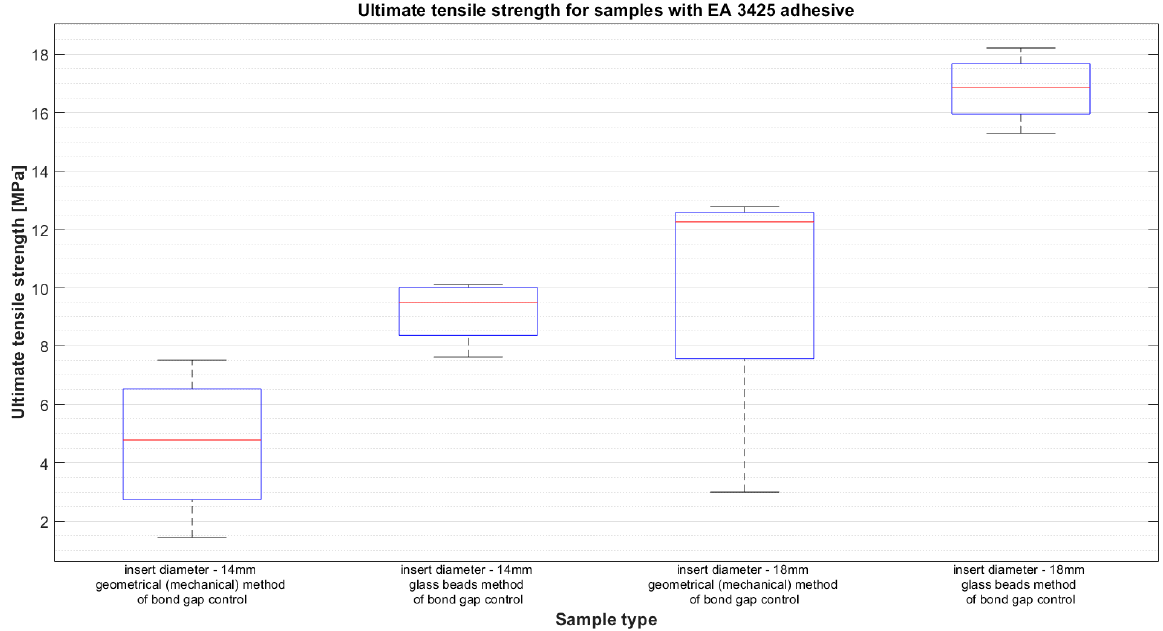
Figure 7. Ultimate tensile strength for samples with EA 3425 adhesive. Table 4. Average results of ultimate